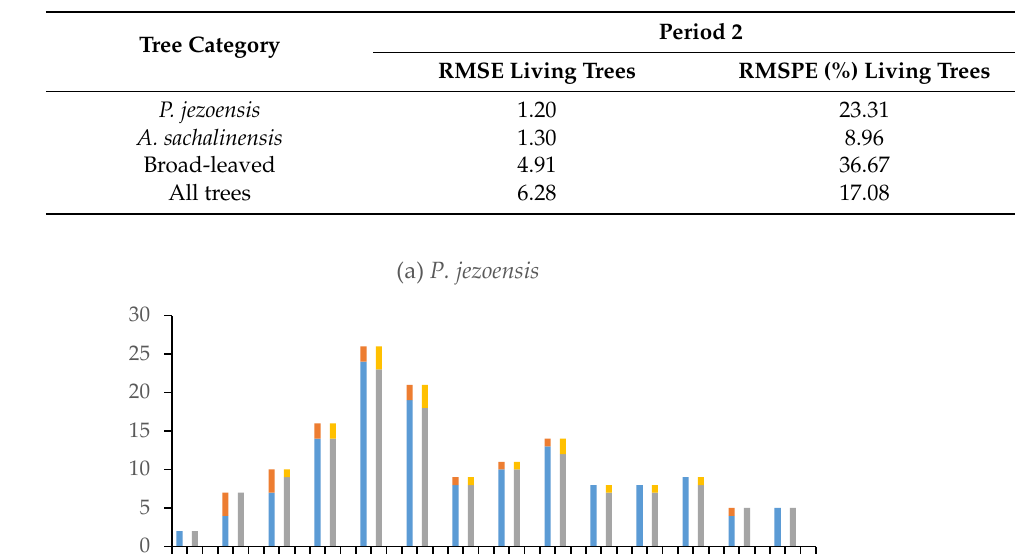
Table 5. Root mean square and root mean square percentage values of each category based on prediction of living trees of period 2 of all sampled plots.